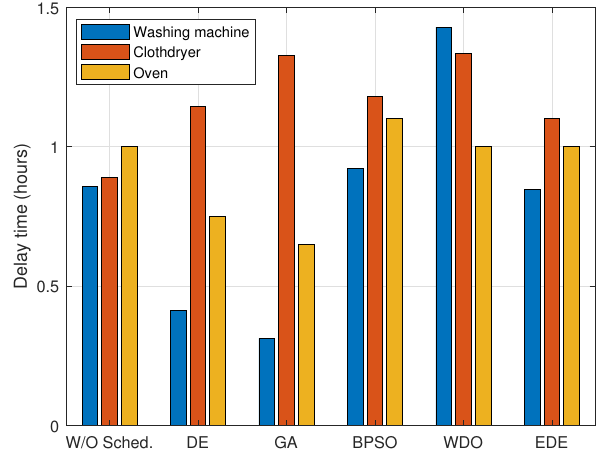
Figure 17. User comfort in aspects of waiting time after scheduling noninterruptible